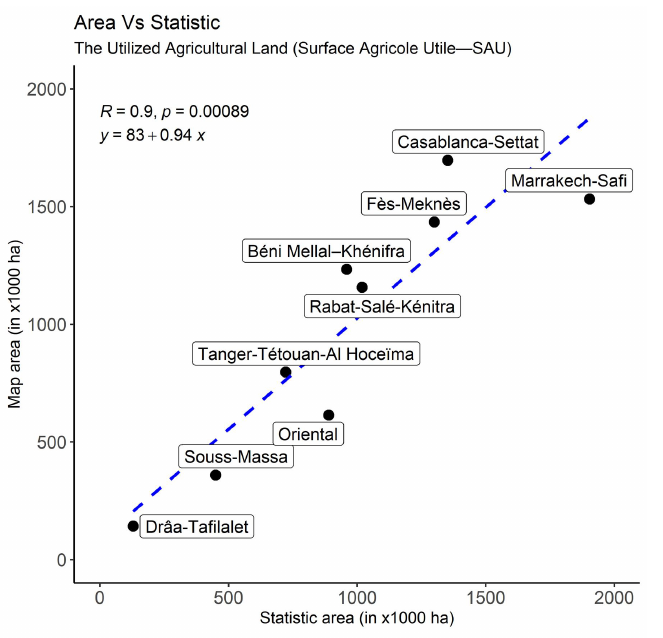
Figure 15. Comparison of province-wise cropland areas derived in this study versus national area statistics of